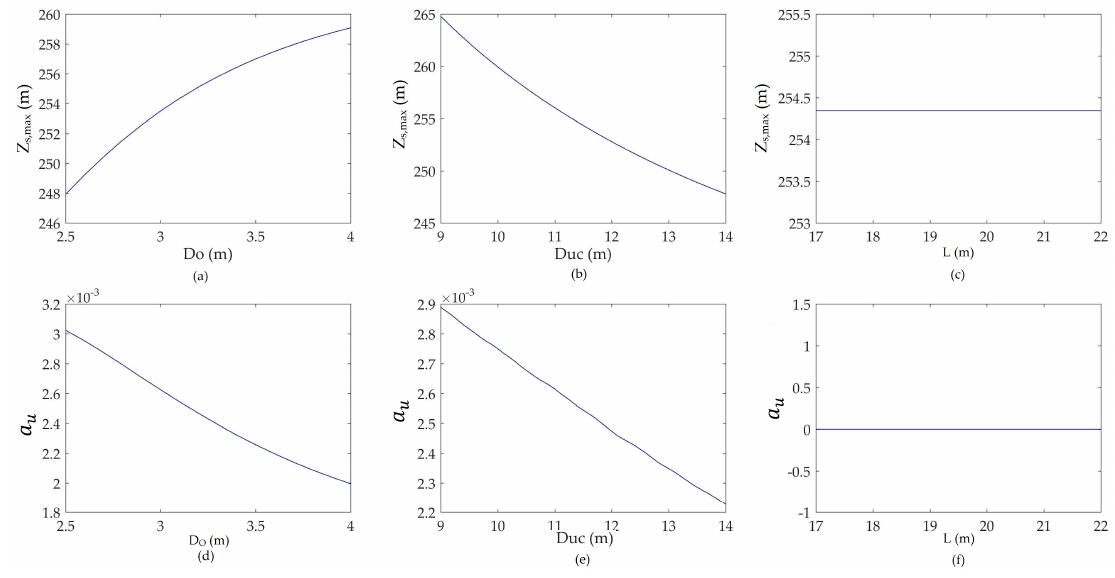
Figure 9. Maximum water level (a) , (b) , (c) and damping factor (d) , (e) , (f) for different diameters of orifice ( Do ), diameters of upper chamber ( Duc ), and length of lower chamber ( L ).